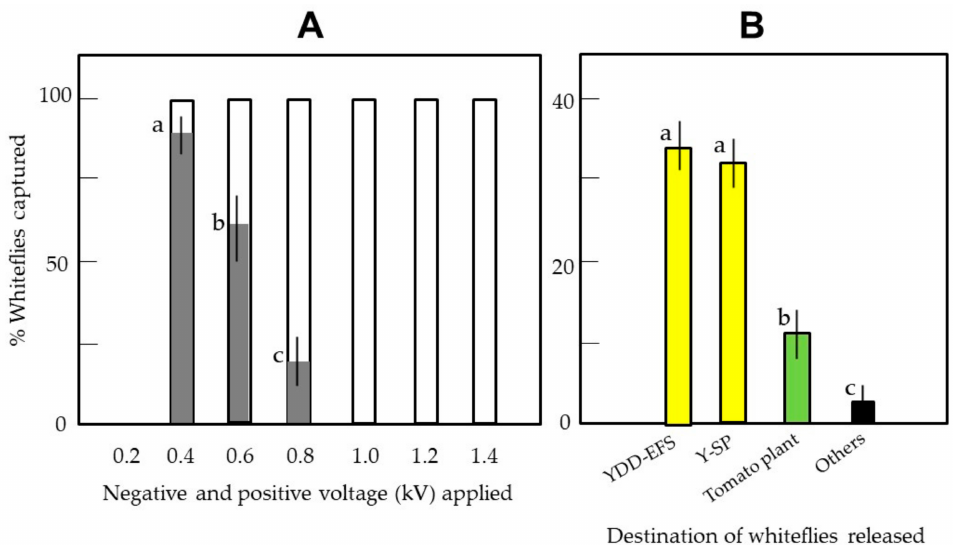
Figure 4. ( A ) The numbers of adult whiteflies captured by the yellow-colored double-charged dipolar electric field screen (YDD-EFS) oppositely charged with different voltages. At each voltage, the paired tubes of the YDD-EFS were oppositely charged with the same negative and positive voltages. Open and gray columns denote whiteflies captured by the charged tubes and those that escaped after capture, respectively. Twenty adult whiteflies were blown toward the apparatus at each voltage. ( B ) The destinations of whiteflies released at the central position among the YDD-EFS, a yellow sticky plate (Y-SP), and a potted tomato plant. Other whiteflies were in the vial or on the floor, walls, or ceiling of the SD-EFS-installed cabinet. A total of 50 whiteflies (in a vessel) were released, and 30 min later, the whiteflies in various places were counted. In both experiments, the means and standard deviations were calculated using five experimental replicates. The letters (a–c) in each vertical column indicate significant differences ( p < 0.05) as revealed by a Tukey’s